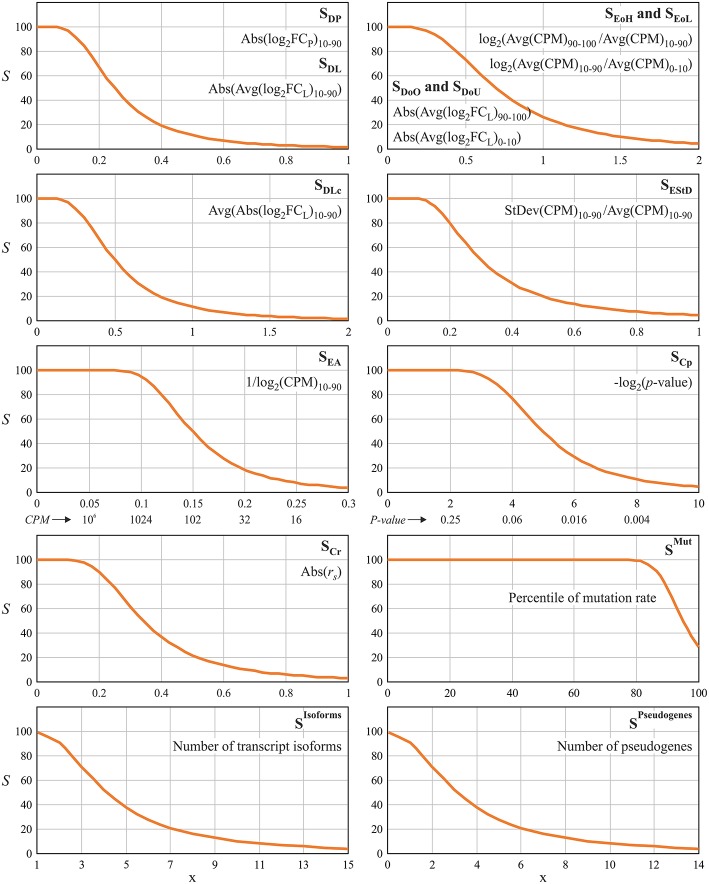
Scoring functions used for evaluation of gene suitability for qPCR data normalization. Percentiles, which were taken into calculation, are indicated as a subscript. Abs(…), absolute value; Avg(…), mean value; CPM, counts per million, gene expression level; FCP, ratio of the average CPM in a pool of tumor samples to the average CPM in a pool of normal samples; FCL, ratio of CPM values between tumor and matched normal tissue (per each paired sample); StDev(…), standard deviation; rs, Spearman's correlation coefficient.